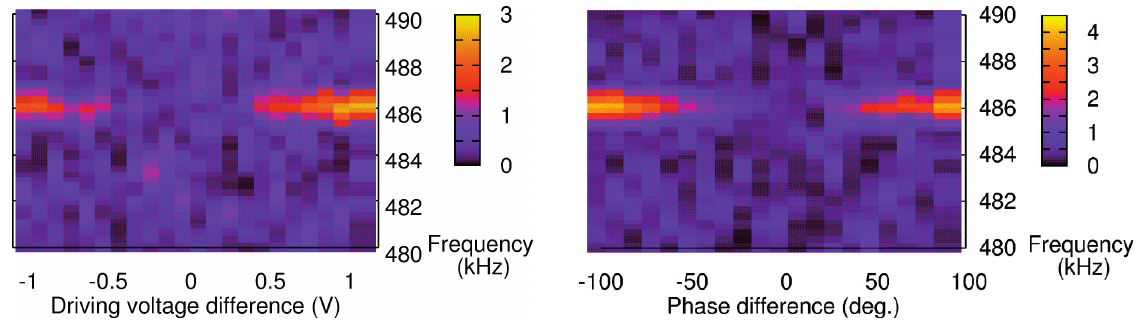
Figure 5. Fast Fourier Transform-based characterization of the PA signal with a Phase-locked loop operating at 486.2 kHz and for various DVs ( Left ) or phase differences ( Right ).